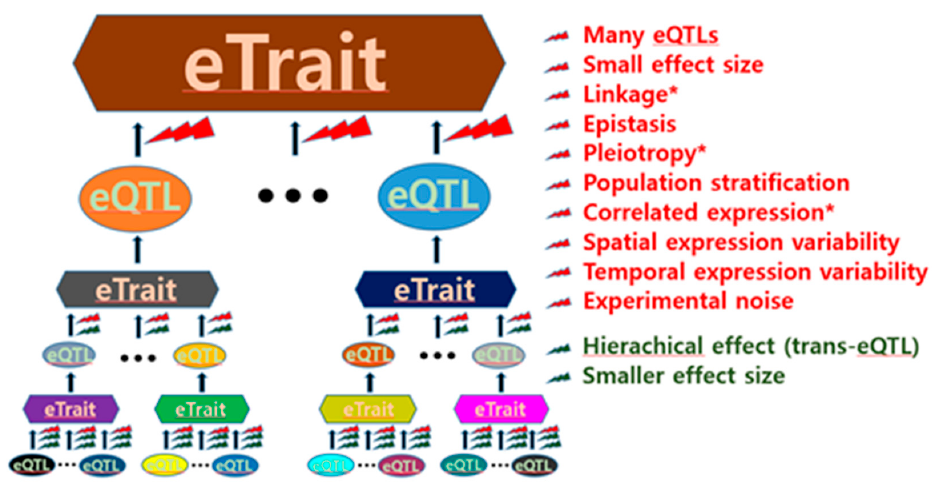
Figure 1. Obstacles to expression quantitative trait locus (eQTL) identification. General obstacles to both cis-eQTL and trans-eQTL identification are presented in red, whereas obstacles to only trans- eQTL identification are presented in dark green. The asterisk indicates obstacles that increase the difficulty of inference of causality.